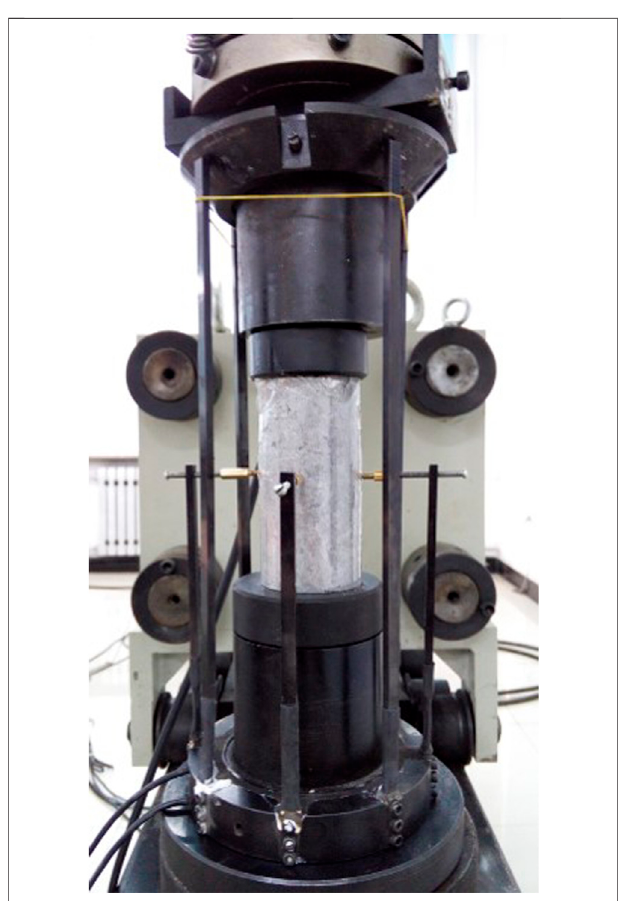
FIGURE 5 | Platform for uncon fi ned compressive strength testing of cemented coal